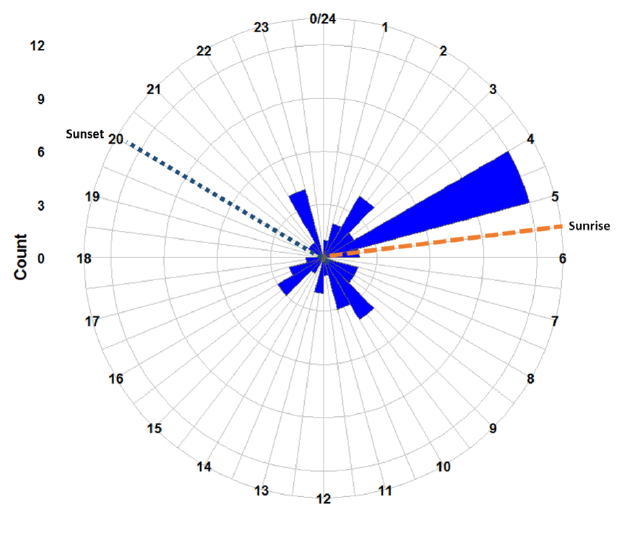
Fig. 7 . Diel variation (hrs, local time) of postbreeding departure times of Arctic Terns ( Sterna paradisaea ; n = 52) from western North Atlantic study area during 2013. Dashed lines show local times of sunrise (orange) and sunset